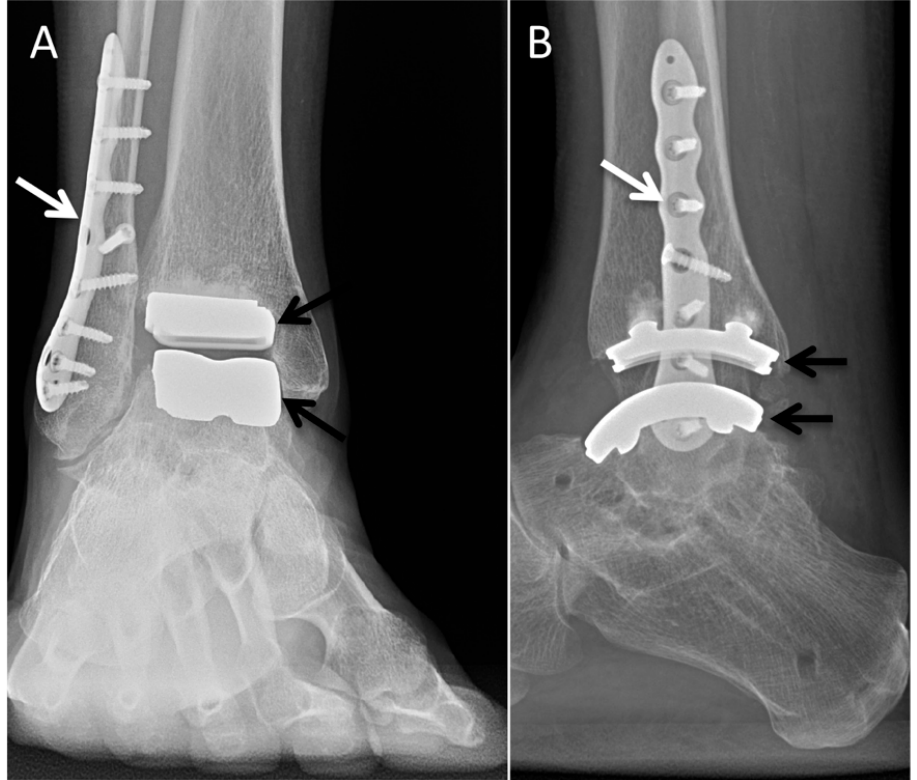
Figure 13. Mobile-bearing total ankle arthroplasty. AP ( A ) and lateral ( B ) radiographs demonstrating well-seated tibial and talar components (black arrows) without abnormal lucency or fracture. Fibular osteotomy (white arrows).